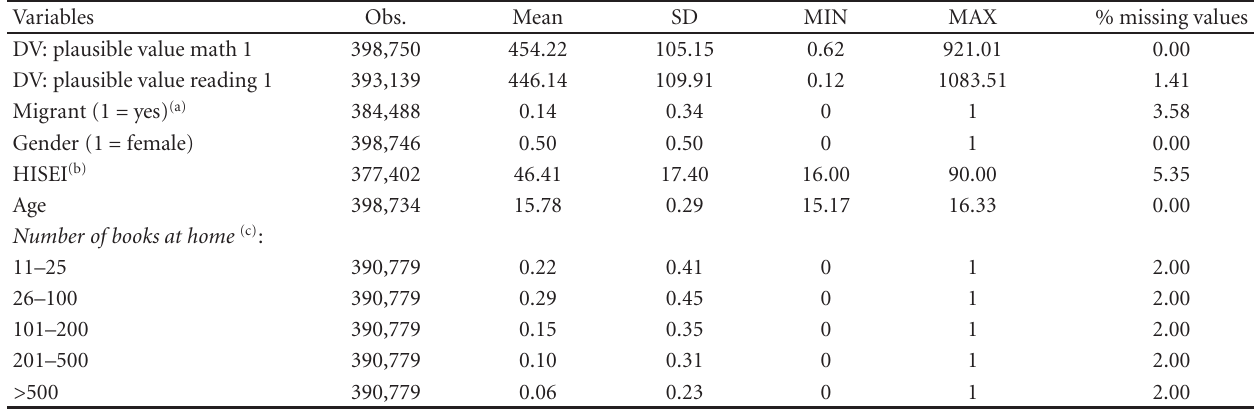
Table 3: Variables on student level ( n = 398,750; weighted by “final student